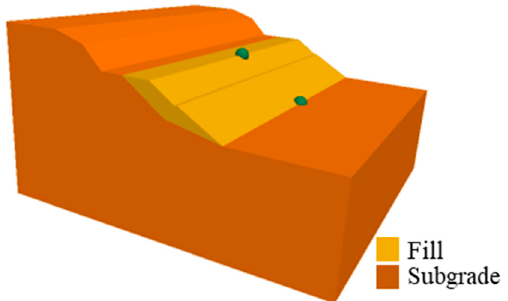
Figure 7. Numerical model and numerical monitoring points of the cut-and-fill subgrade.